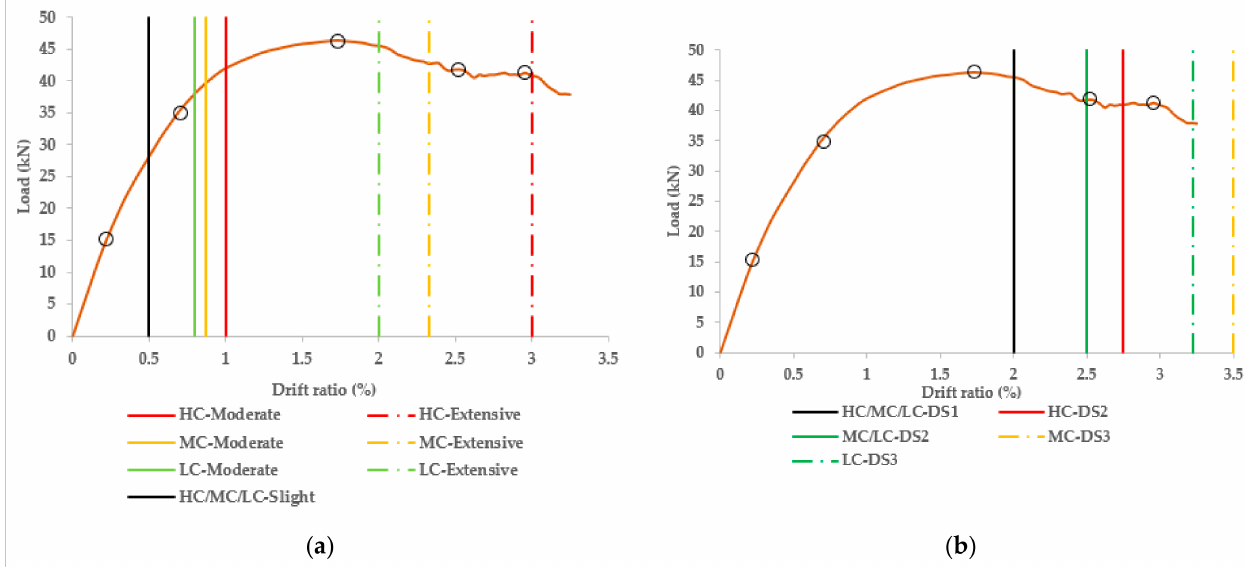
Figure 11. The threshold value of damage states defined by Hazus-MH 2.1 ( a ) and FEMA P-58 ( b ) in the load-drift ratio curve.